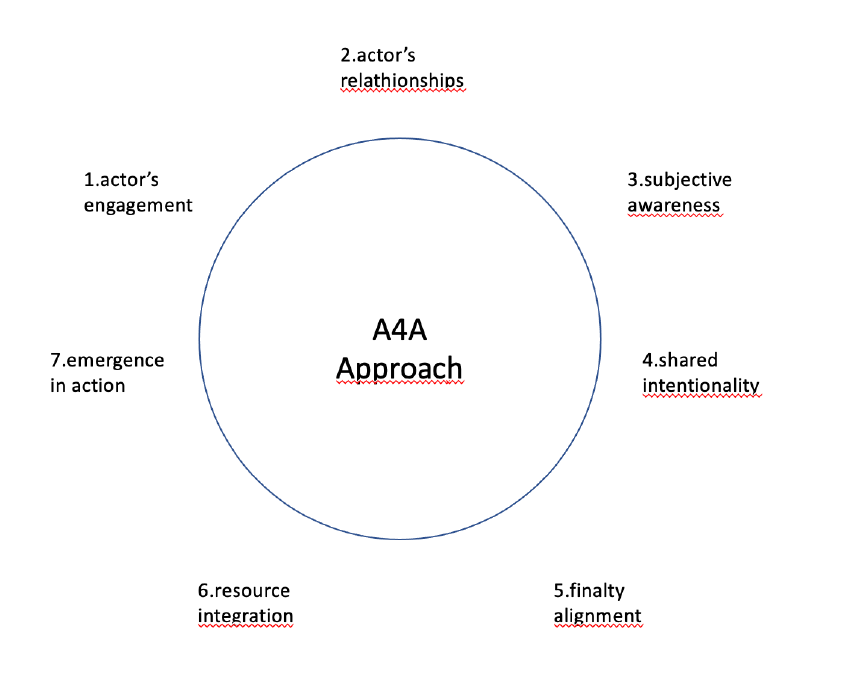
Fig.1. Authors’ elaboration. A4A